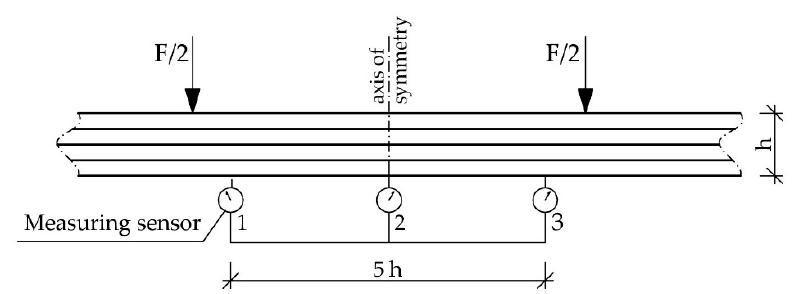
Figure 4. Arrangement of measuring bases in the front and back of the reinforced beams [dimensions in mm].